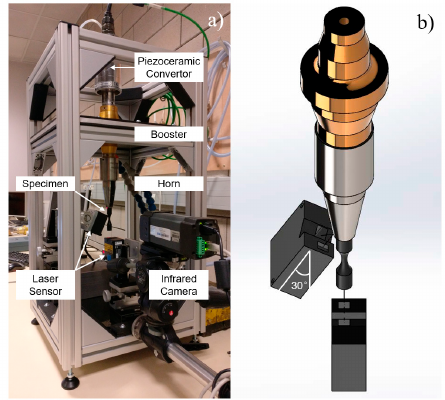
Figure 1. Schema of ultrasonic fatigue test device: ( a ) test device with data acquisition system, ( b ) laser sensor probes’ arrangement.